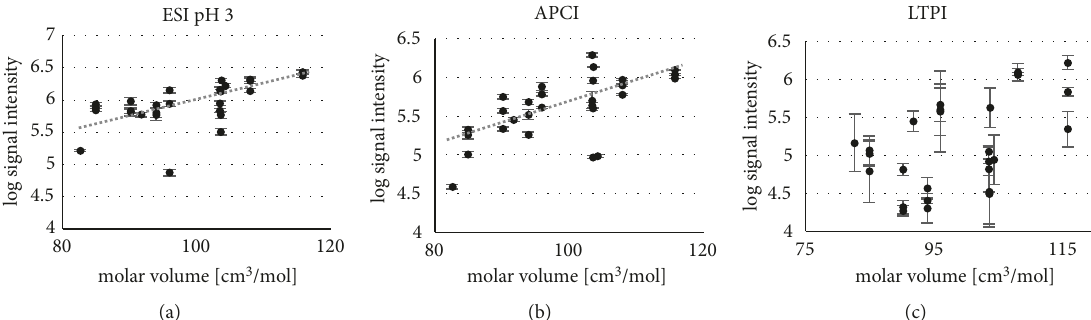
Figure 10: Log signal intensity (peak height) in dependency on the molar volume for (a) ESI pH = 3, (b) APCI, and (c) LTPI (reprinted with permission from Springer [129]